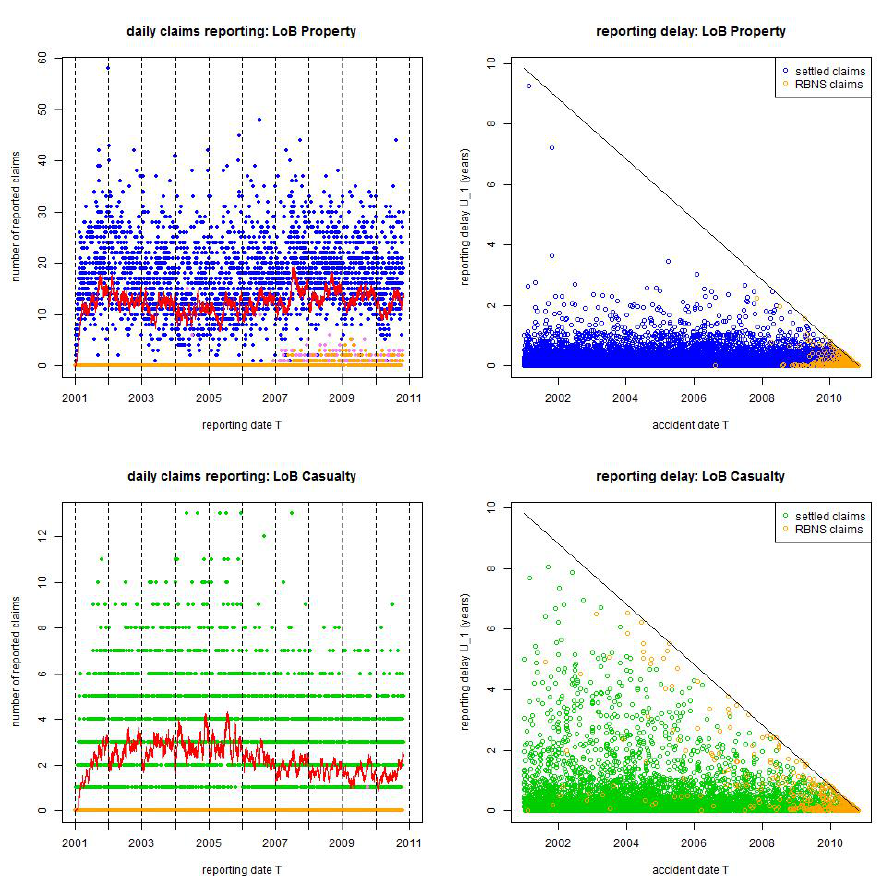
Figure 2. Observed and reported claims counts from 1/1/2001 until 31/10/2010: (top) LoB Property colored blue and (bottom) LoB Casualty colored green. The lhs gives daily claims reporting; the red lines are the 30 days rolling averages; violet dots show claims reporting on Saturdays and orange dots claims reporting on Sundays. The rhs plots accident dates T (cid:96) versus reporting delays U (cid:96) = S (cid:96) − T (cid:96) ; the upper-right (white) triangle corresponds to the missing data (IBNYR claims); the blue/green dots illustrate reported and settled claims; the orange dots reported but not settled (RBNS) claims.